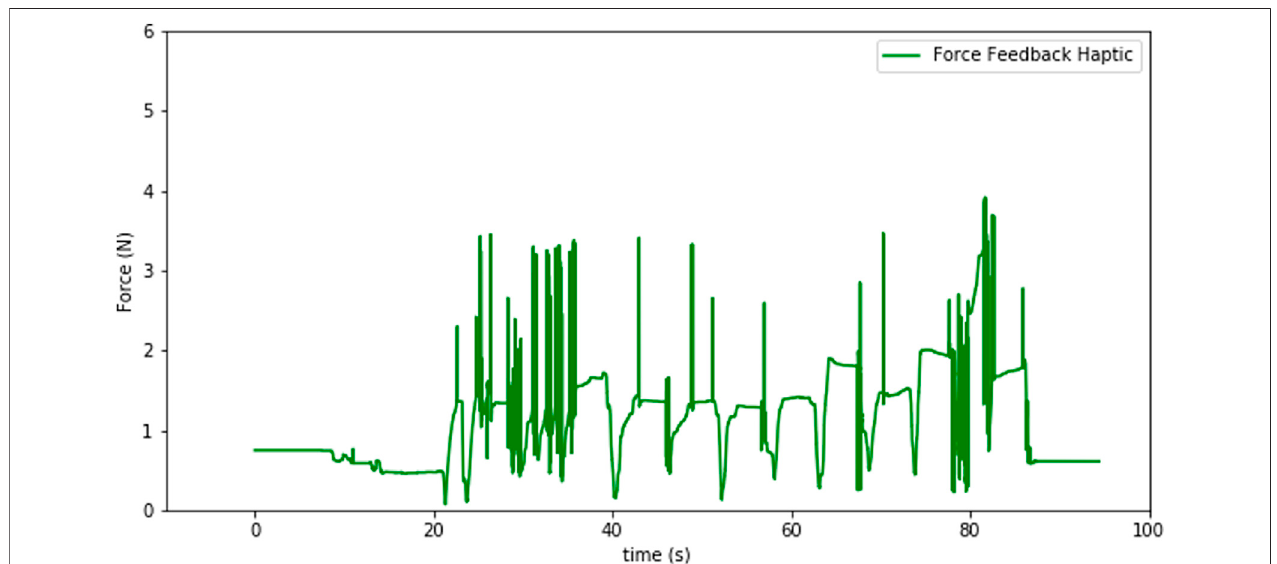
FIGURE 9 | Force feedback sensation at the haptic device.